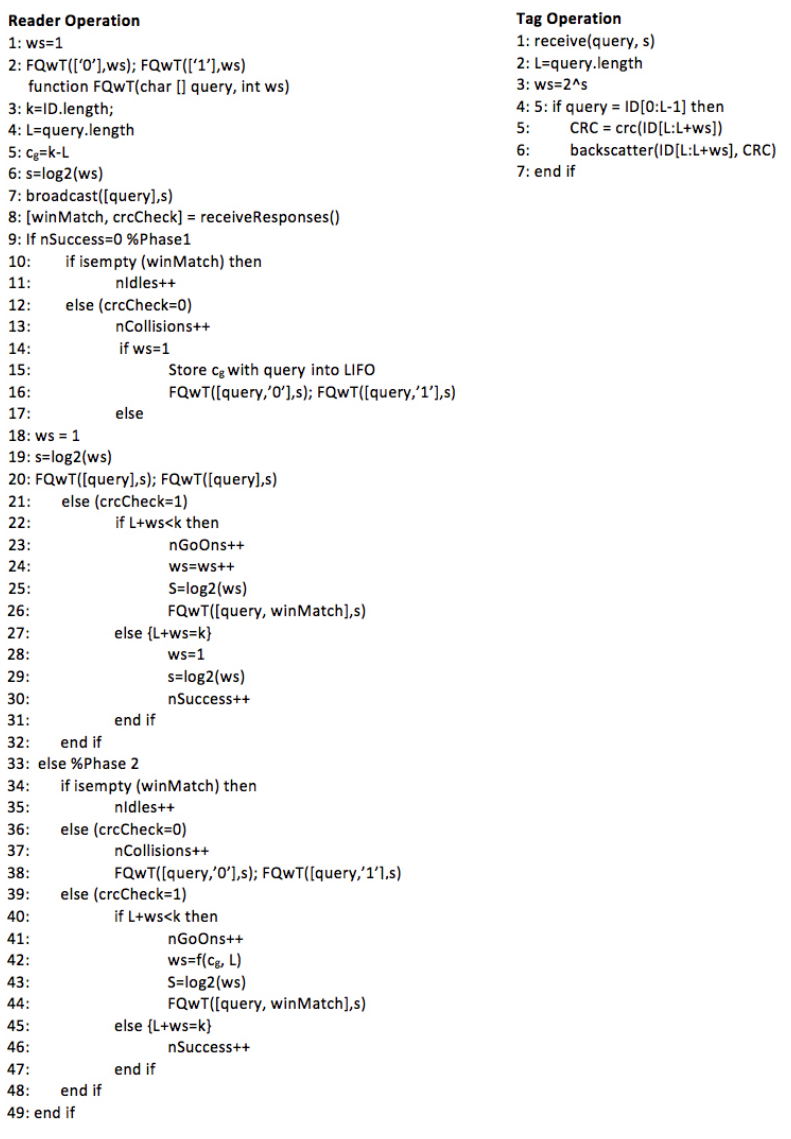
Figure 11. Pseudo-code of FQwT. First the reader operation is presented, then the tag